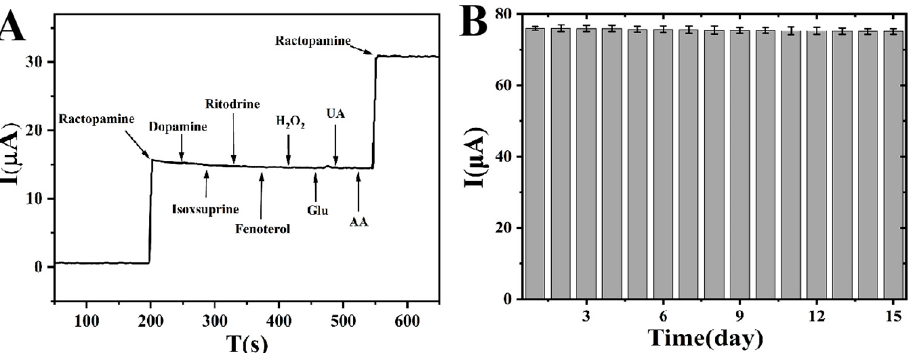
Figure 10. I-T diagram ( A ) in response of AuNPs@COFs electrode in 0.1 mol/L PBS solution when ractopamine, dopamine, isoxsuprine, ritodrine, fenoterol, H 2 O 2 , Glu, UA, AA and ractopamine were added in turn (the concentration of ractopamine added was 0.3 mmol/L, and the concentration of interfering substances added was 3 mmol/L); stability of the electrochemical sensor based on AuNPs@COF nanocomposites ( B ).